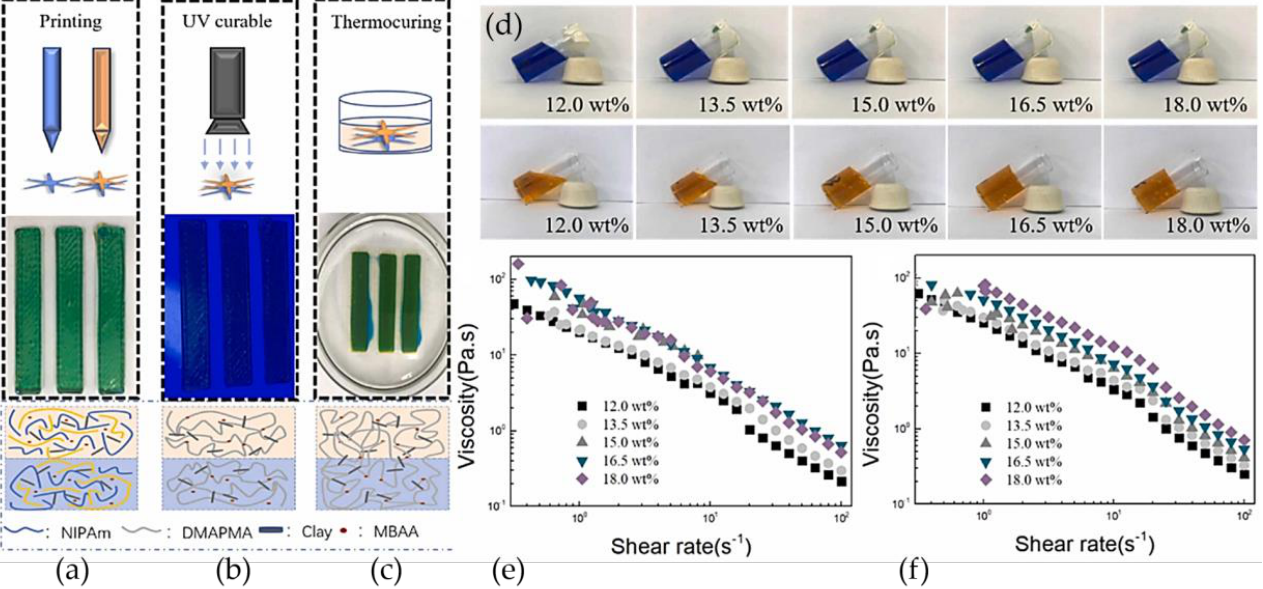
Figure 20. ( a ) Print process and print result photos, ( b ) photo of photocuring state, ( c ) thermo-curing process, ( d ) tilted photos of the two printing fluids with different clay content, ( e , f ) viscosity shear rate of top layer and bottom layer [145].